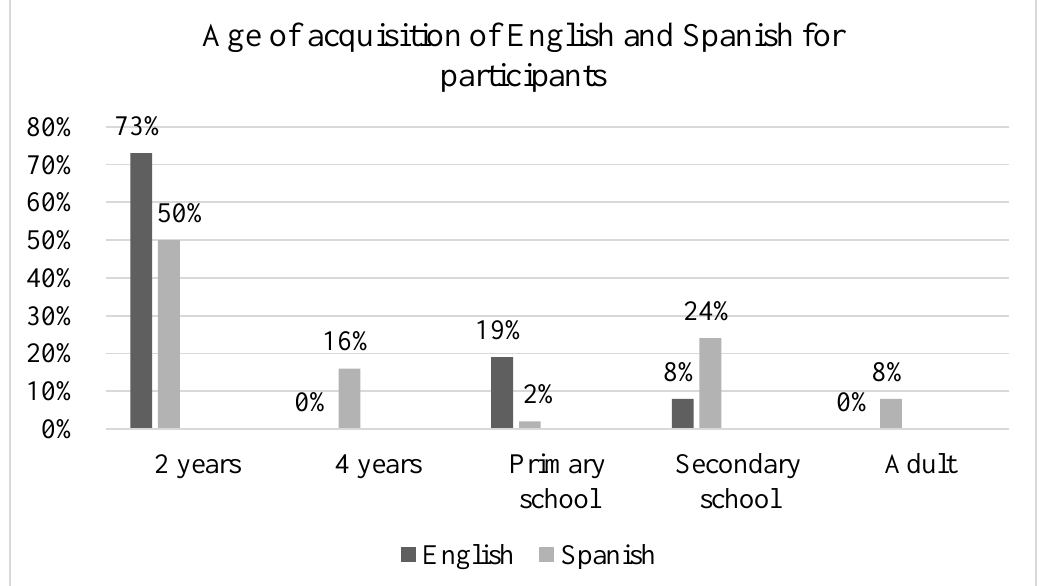
Figure 1. Age of acquisition of English and Spanish for